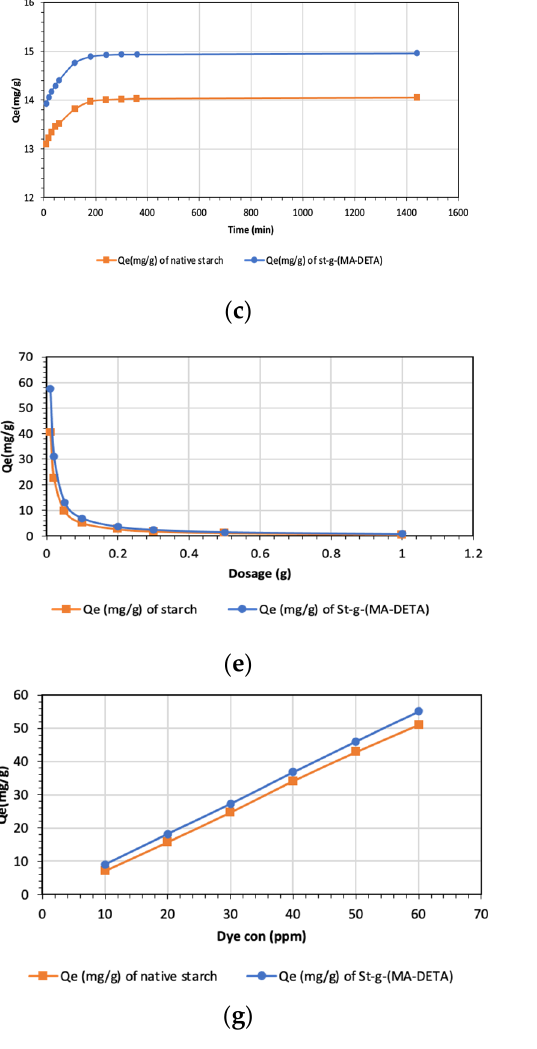
Figure 14. Adsorption of celestine blue from water at ( a , b ) different pHs ( c , d ) different times ( e , f ) different amounts of bio sorbent and ( g , h ) different initial dye concentrations.